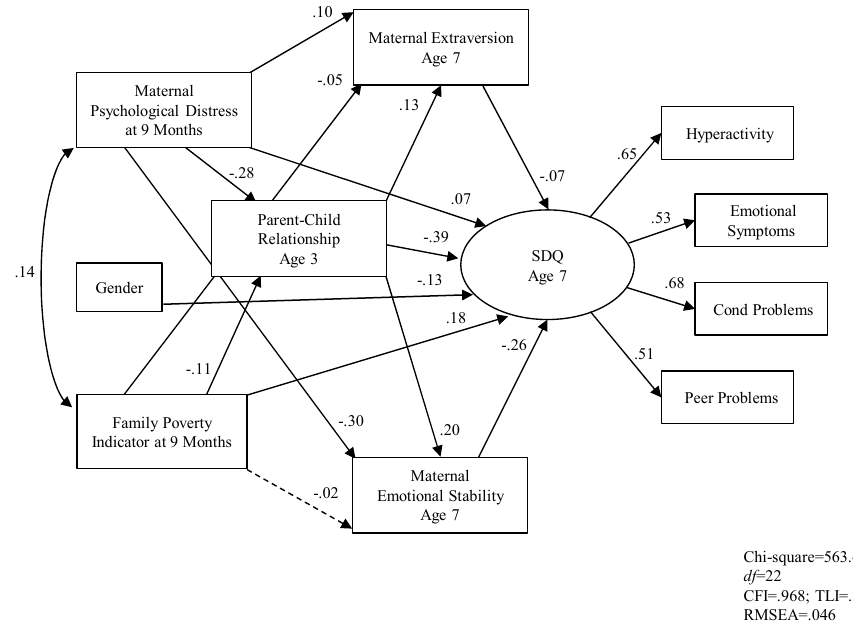
Figure 1. Predicting children’s behavioural problems path